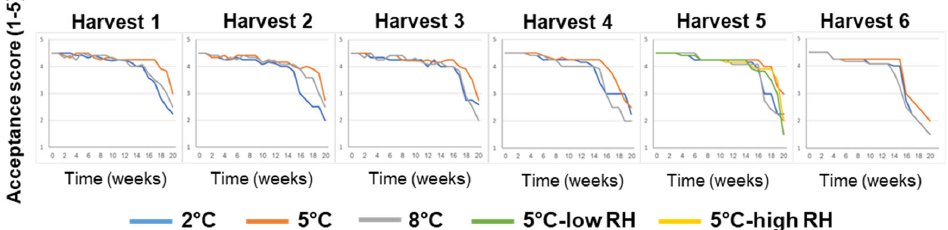
Figure 4. Effects of various pre ‐ harvest and postharvest features on the acceptance scores of ‘Rus ‐ tenburg’ navel oranges harvested from six different orchards. The harvest times and yields of the different orchards are presented in Table 1. The postharvest features included storage temperature (2, 5 or 8 °C) and storage RH (70, 90 or 95%). Fruit quality was evaluated every week after one additional week of storage under shelf conditions (at 20 °C) for a period of 20 weeks.